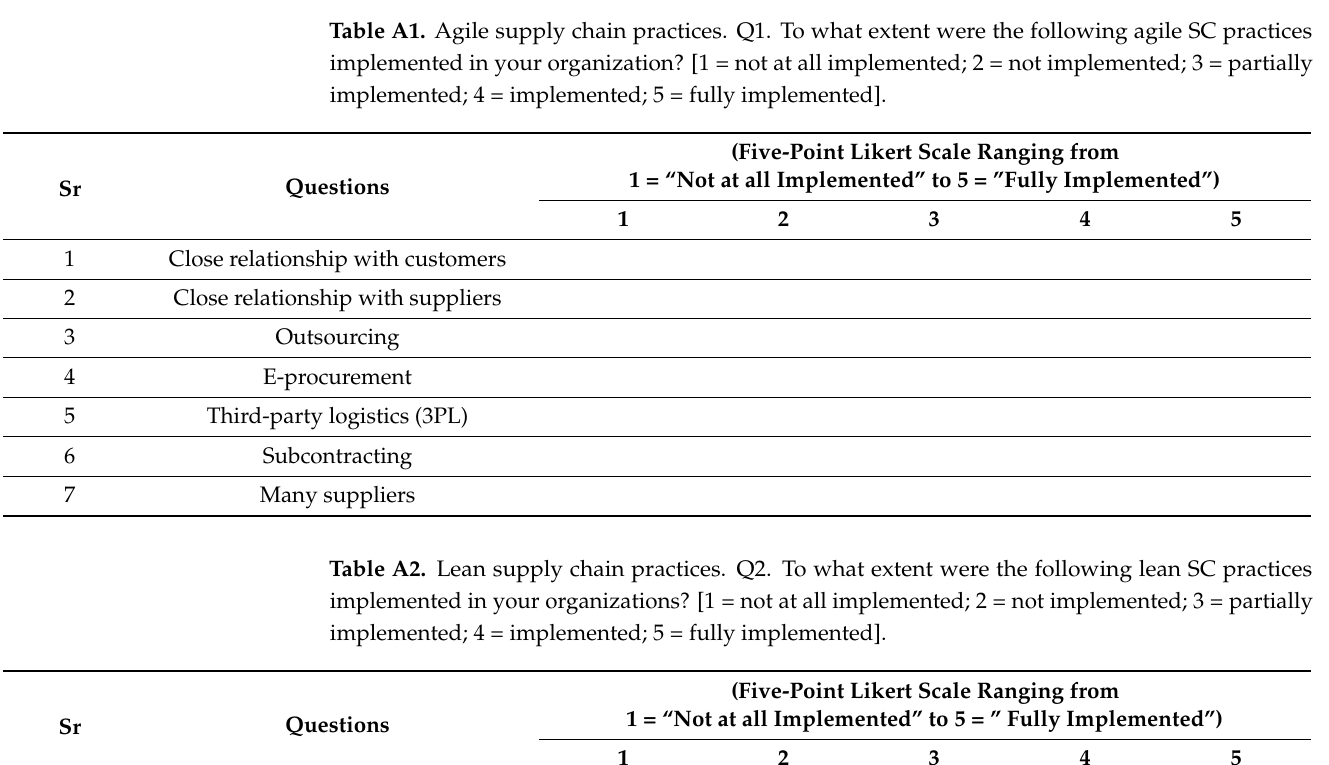
Table A1. Agile supply chain practices. Q1. To what extent were the following agile SC practices